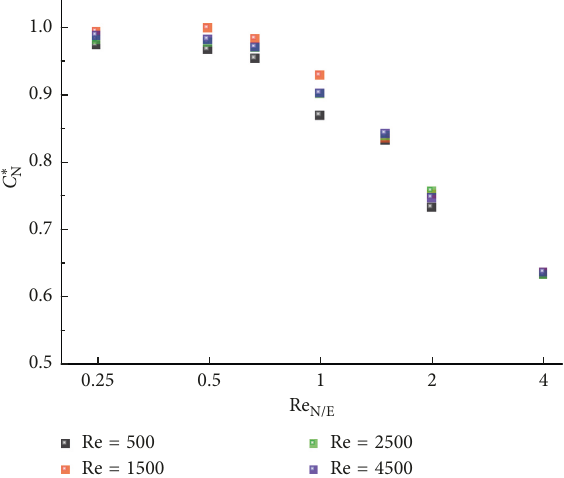
Figure 7: Normalized north outlet concentration C ∗ at cross Re N/E versus pipe N